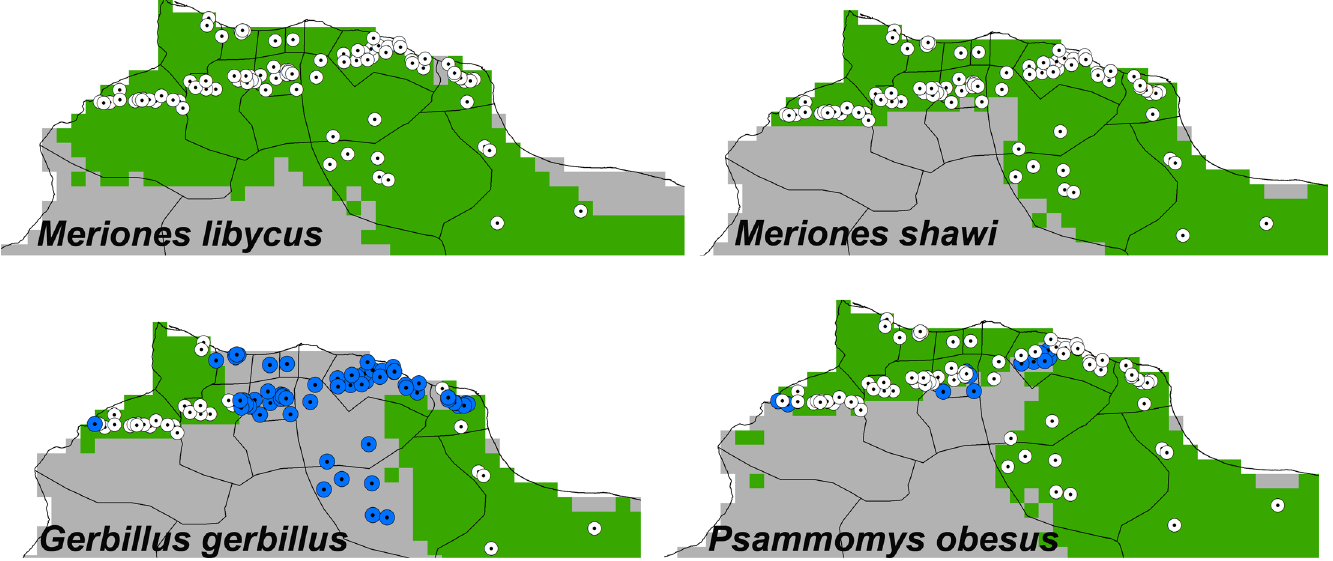
Fig 6. Relationship of additional independent human case records to the areas where pairs of vector Phlebotomus papatasi and mammal reservoir species can occur. Green areas are areas of overlap between P . papatasi and each of the potential mammal reservoirs; white dotted circle represent localities where human cases were predicted successfully; blue dotted circles indicate case records not predicted successfully by the model combination.